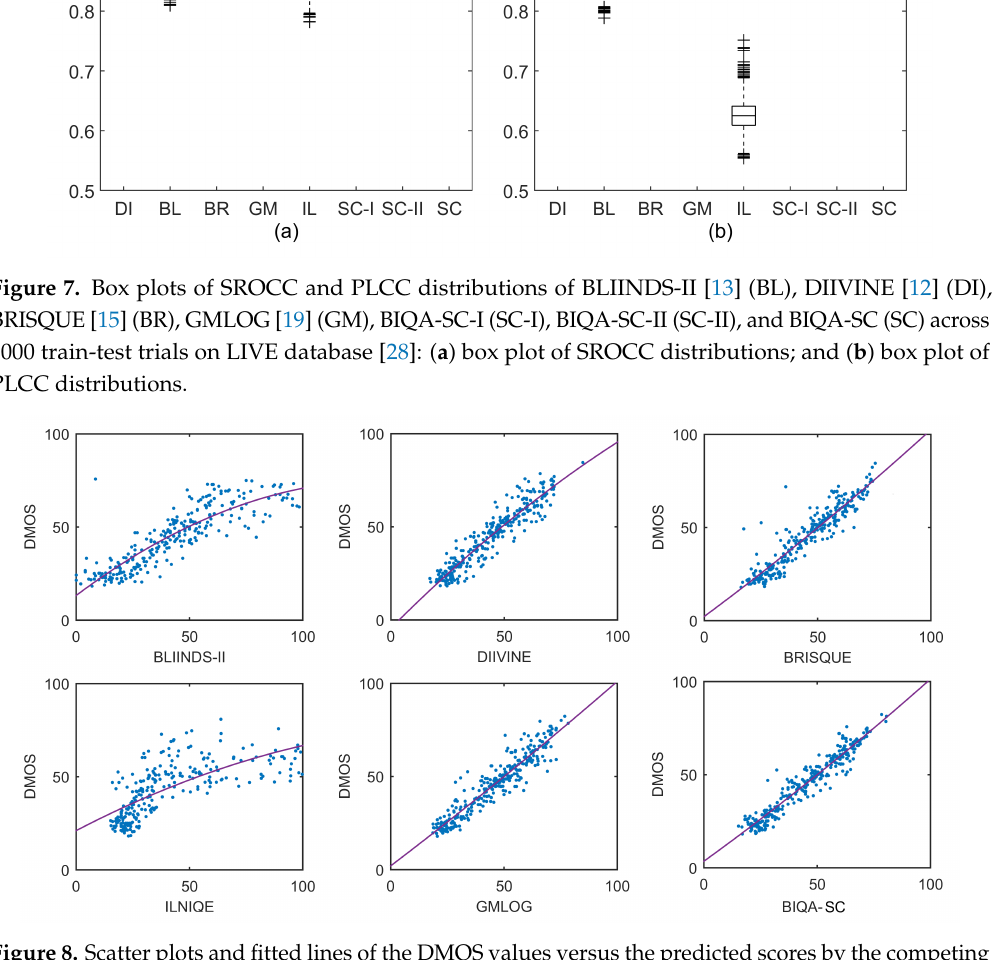
Figure 8. Scatter plots and fitted lines of the DMOS values versus the predicted scores by the competing algorithms on LIVE database